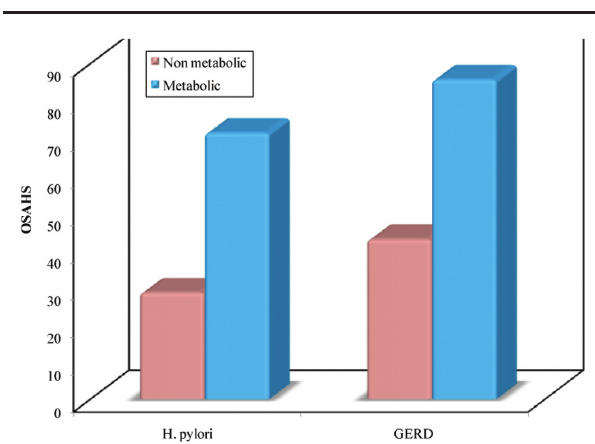
Comparison between the two studied groups according to Helico- bacter pylori and gastroesophageal reflux disease. OSAHS, obstruc-